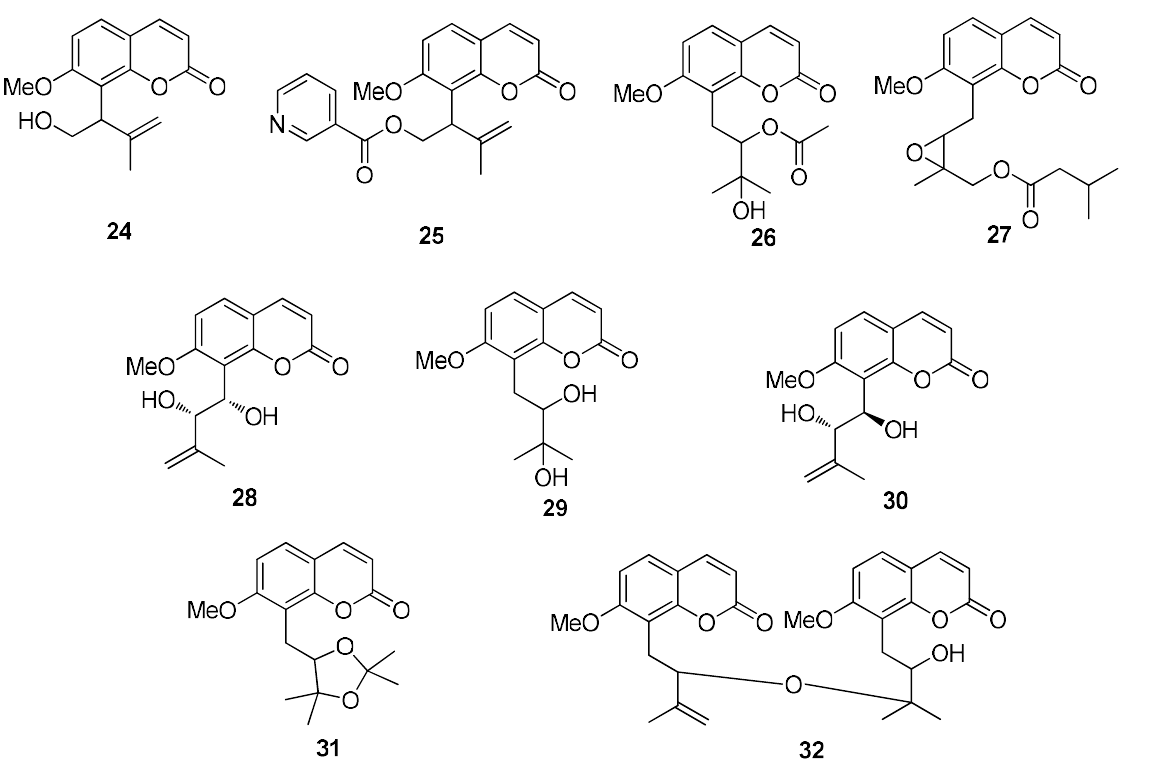
Figure 1. The structures of coumarins from Murraya exotica L.